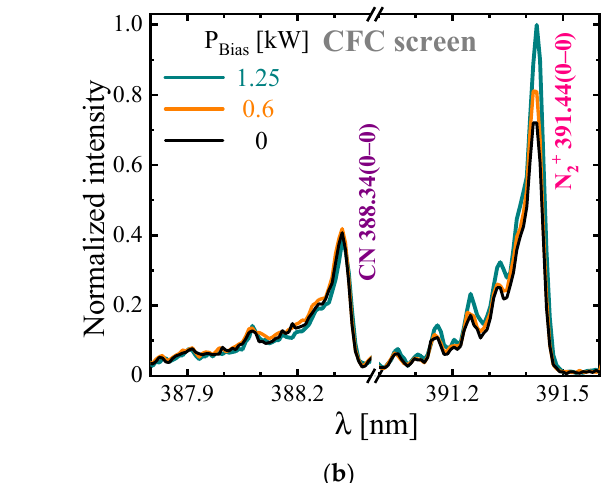
( b ) Figure 8. Concentrations of CH 4 , NH 3 , HCN, and C 2 H 2 measured as functions of the bias plasma power during ASPNC treatment using a steel AS ( Φ CH4 = 4 slh) ( a ) and a CFC-AS ( b ) at H 2 :N 2 = 1:1, T = 460 °C, Φ Total = 80 slh, and p = 3 mbar.